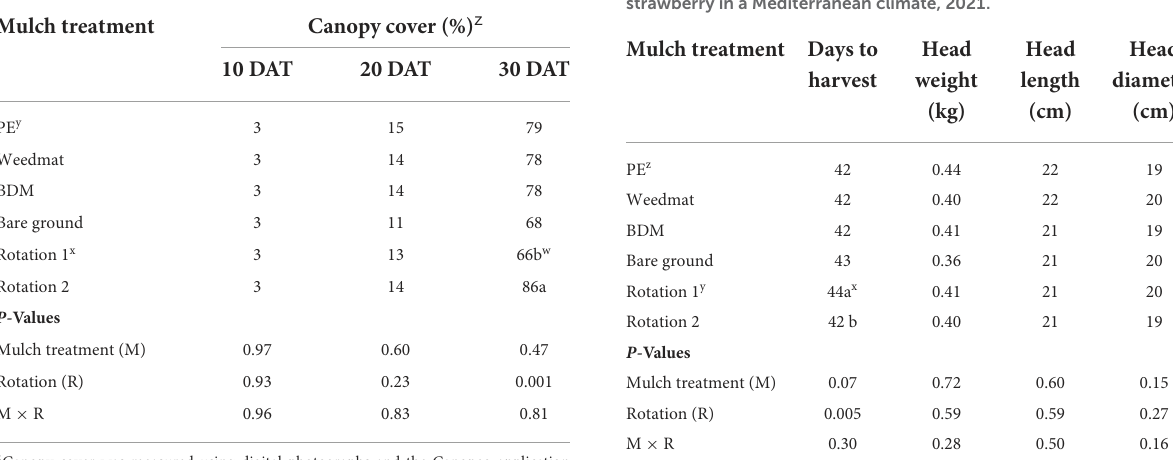
TABLE 7 Days to harvest, mean head weight (kg), length (cm), and diameter (cm) of lettuce cv. Green Star grown on a raised bed with polyethylene (PE), weedmat, soil-biodegradable plastic mulch (BDM), or bare ground treatments in two different rotation schemes following